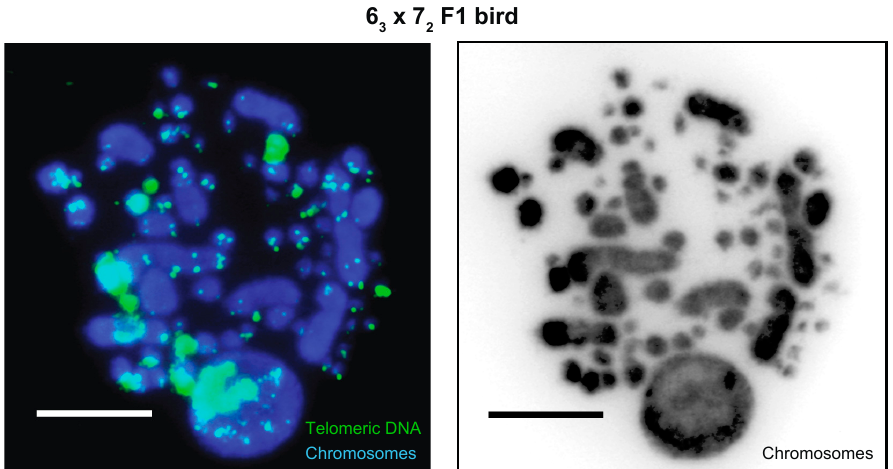
Figure A1. Telomeric DNA profile for mitotically-dividing splenic cells of a line 6 3 × 7 2 F 1 bird indicated by telomere FISH.